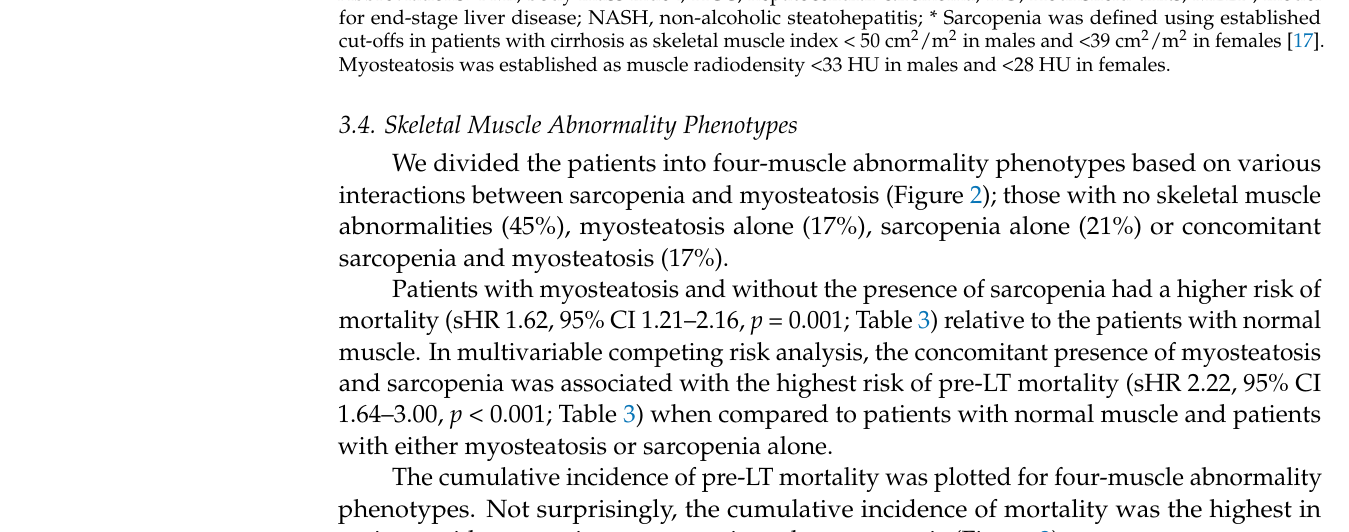
composed of the low attenuation muscle whereas, in a patient with normal muscle radiodensity (51 HU, no-myosteatosis), areas with the normal attenuation range are predominant ( B ).